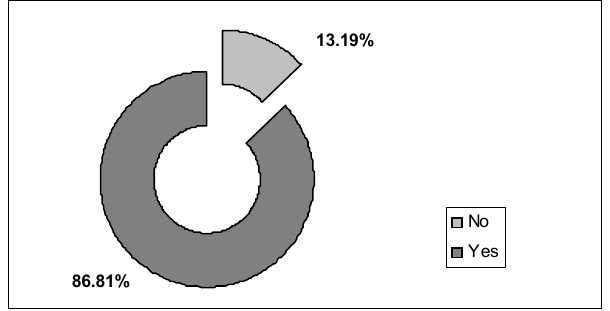
Figure 2: Online brand name